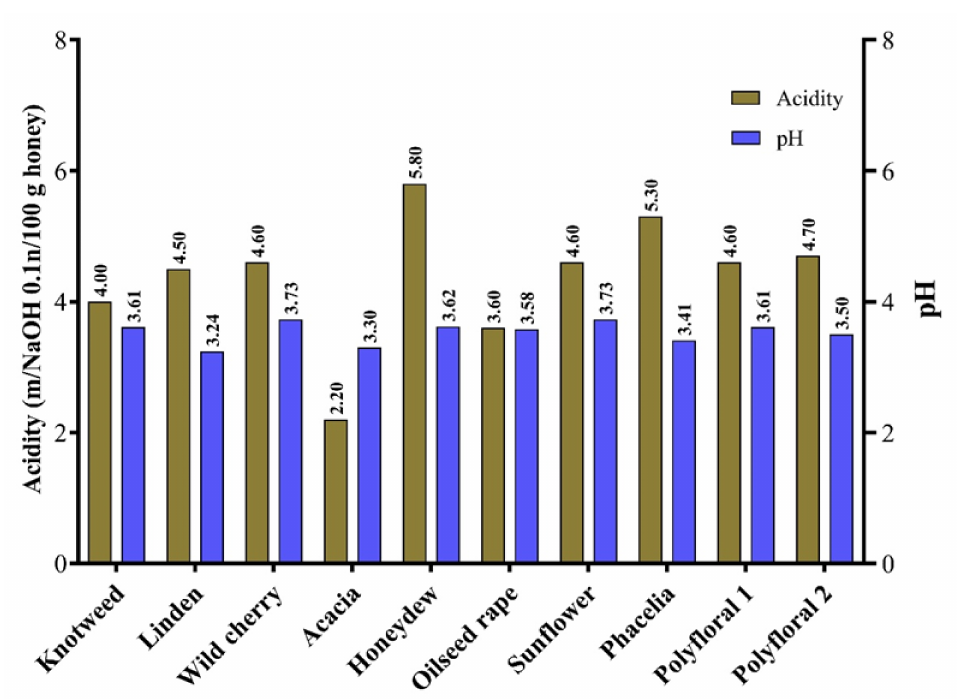
Figure 3. The acidity and pH of the honey samples.